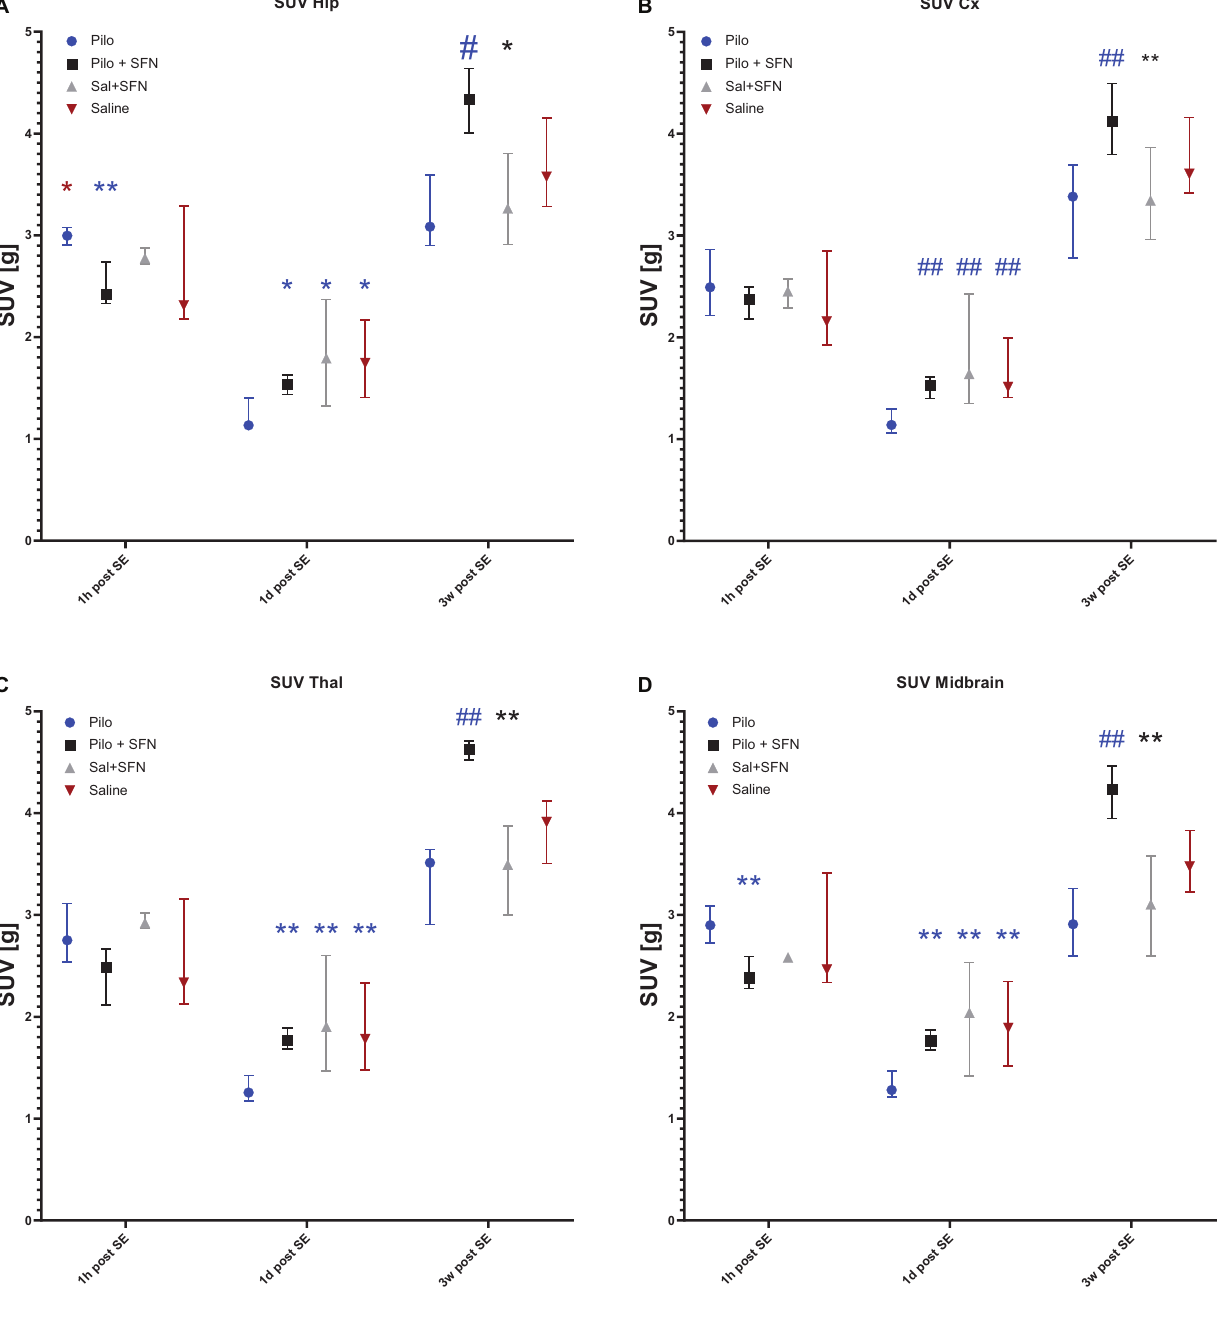
and PCr ( Figure 6D ) in the Pilo + SFN group and a